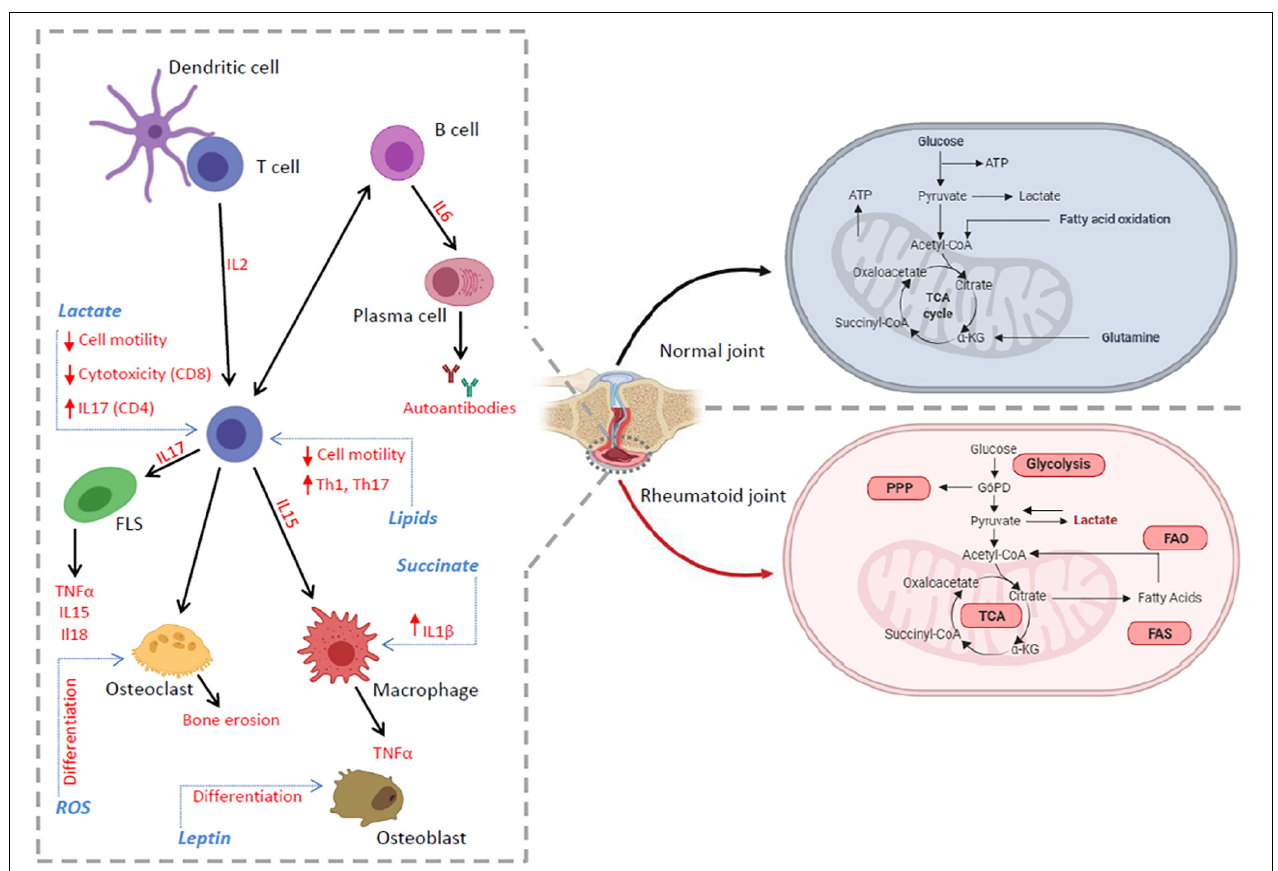
FIGURE 1 | The inflammatory environment in RA synovium. The RA tissue microenvironment is characterized by the accumulation of cytokines, adipo-cytokines and metabolic intermediates produced by the accelerated metabolism of infiltrating and tissue resident immune cells. These events can promote or be the consequence of a dysregulation in several metabolic pathways (red), including glycolysis, TCA cycle, PPP and lipid metabolism, which regulate many cell functions including activation, differentiation, proliferation, autoantibody and cytokine production leading to pro-inflammatory immune responses and the exacerbation of chronic